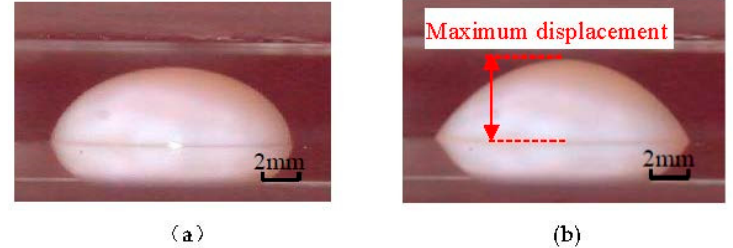
Figure 8. Maximum displacement of polishing slurry under different frequencies.